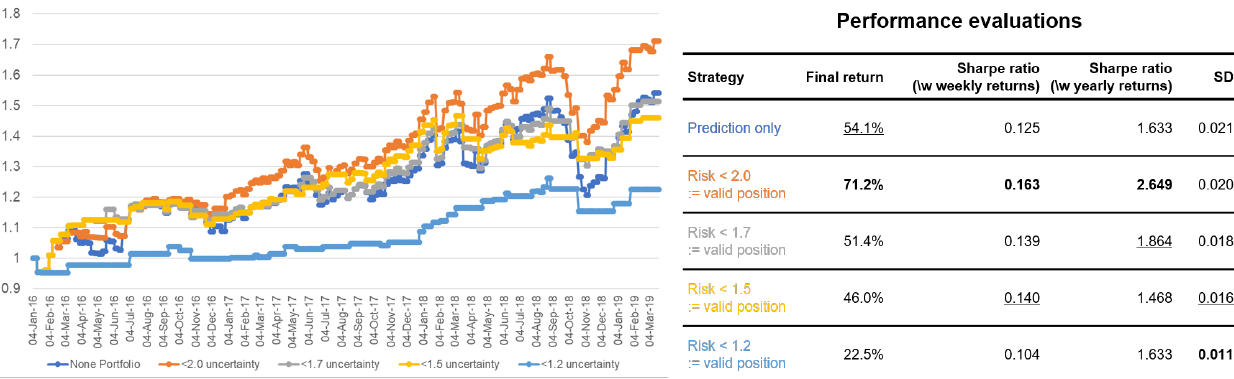
Figure 3. Portfolio performance with different strategies using cGAN-UC. Dark blue indicates a conventional strategy using only the prediction of returns while the others represent the strategies using the both predictions and estimated uncertainty. SD indicates the standard deviation of weekly returns. In each evaluation metric, the best performance is bold, and the second best is